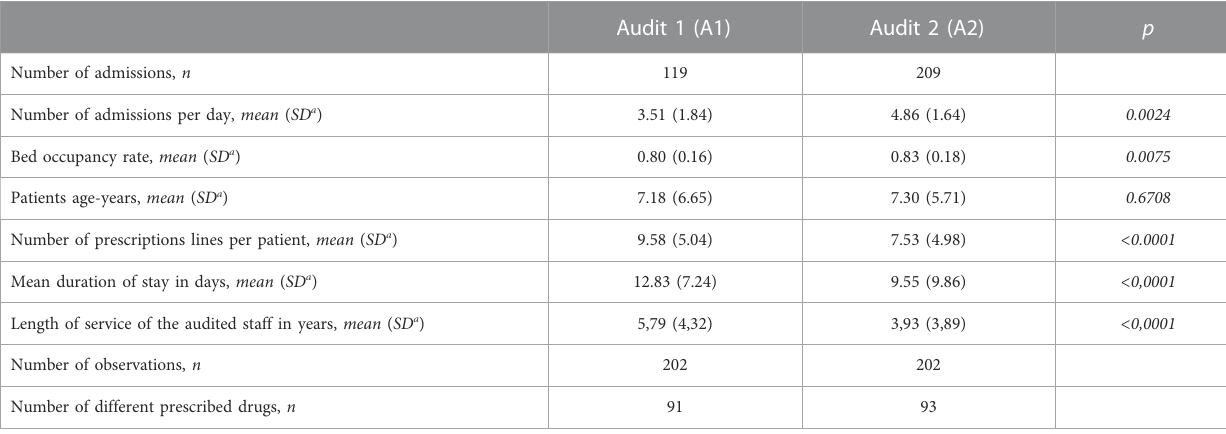
TABLE 1 Audit descriptive characteristics.